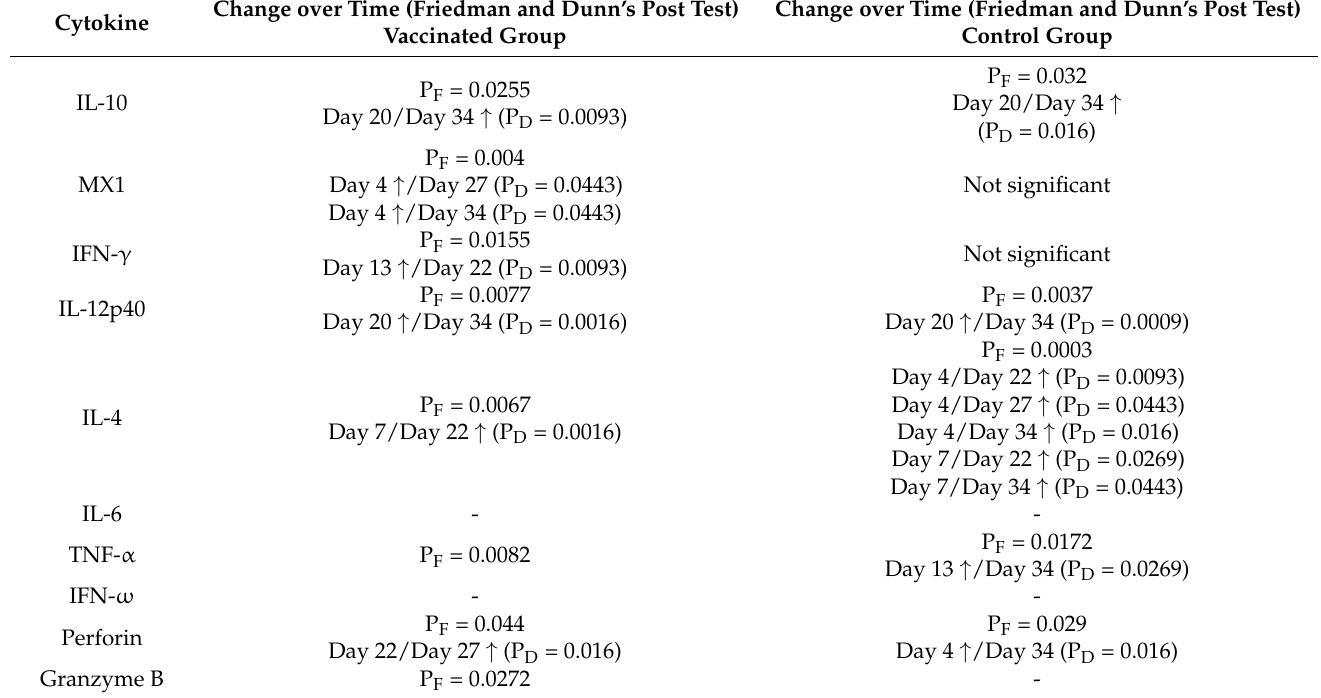
Table A1. Results of Friedman and Dunn’s post test of cytokine mRNA transcription levels after FCV Vaccination I.